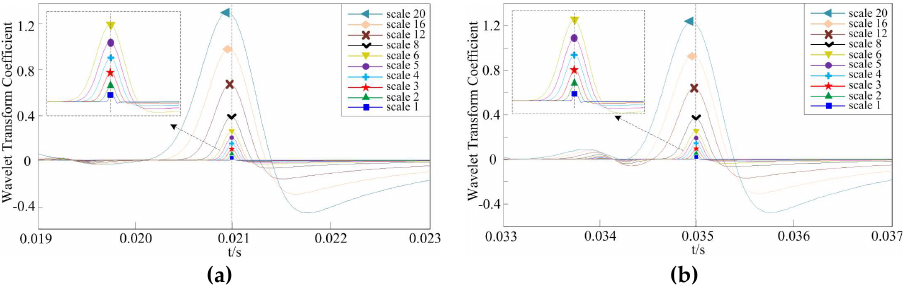
Figure 10. Wavelet Transform Coefficient under various scales: ( a ) Case 1; ( b ) Case